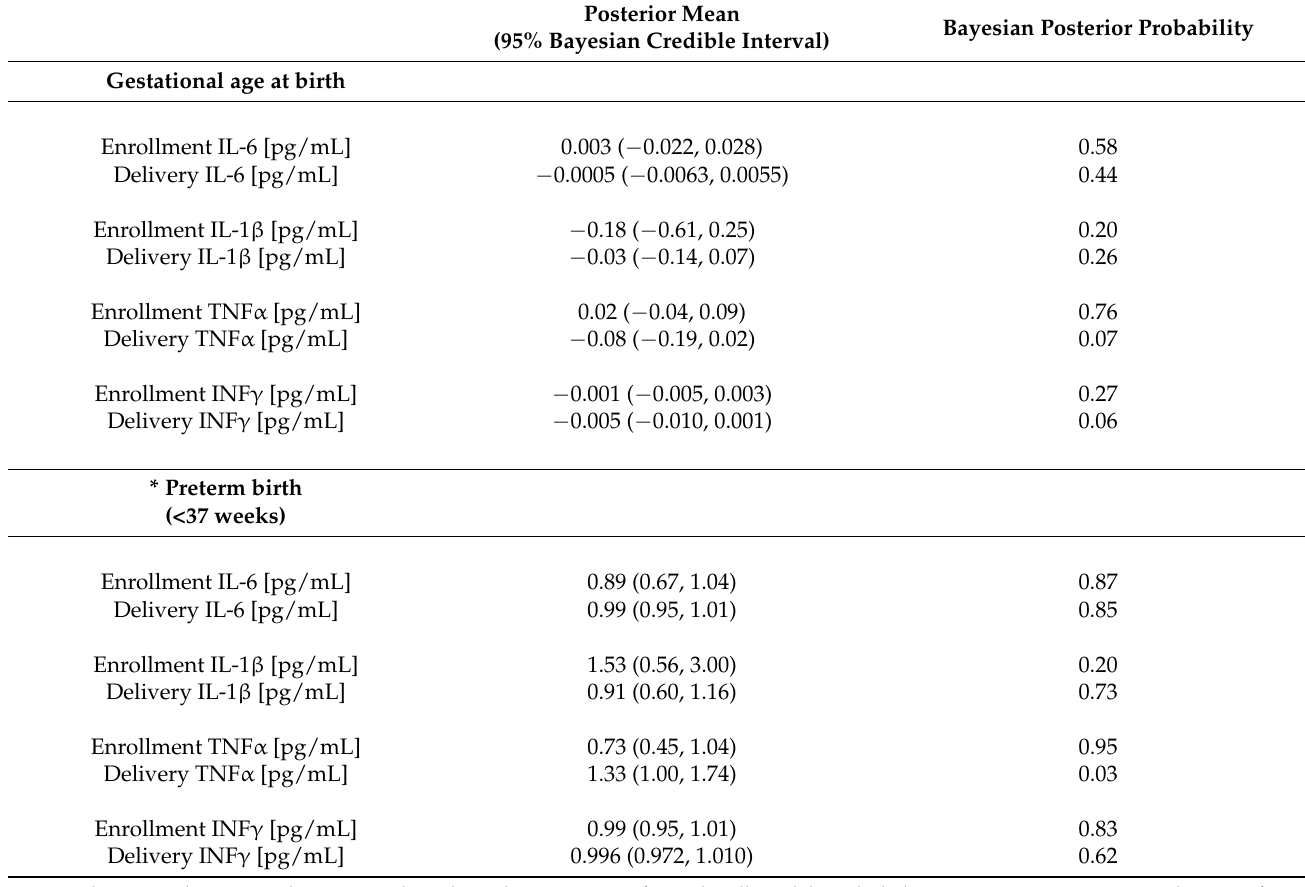
Table 3. Posterior means (Bayesian credible interval) and Bayesian posterior probability for cytokine concentrations and the continuous variable (gestation age at birth) or the binary variable (preterm birth). The means are slopes for gestation age at birth and log-odds ratios for preterm birth. For brevity, the maternal confounder parameter estimates are not shown. Posterior Mean Bayesian Posterior Probability (95% Bayesian Credible Interval)